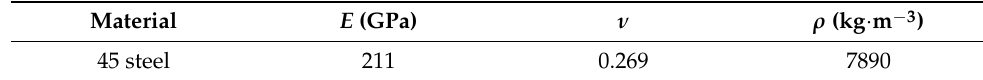
Table 6. Material parameters of the threaded tubes [24].